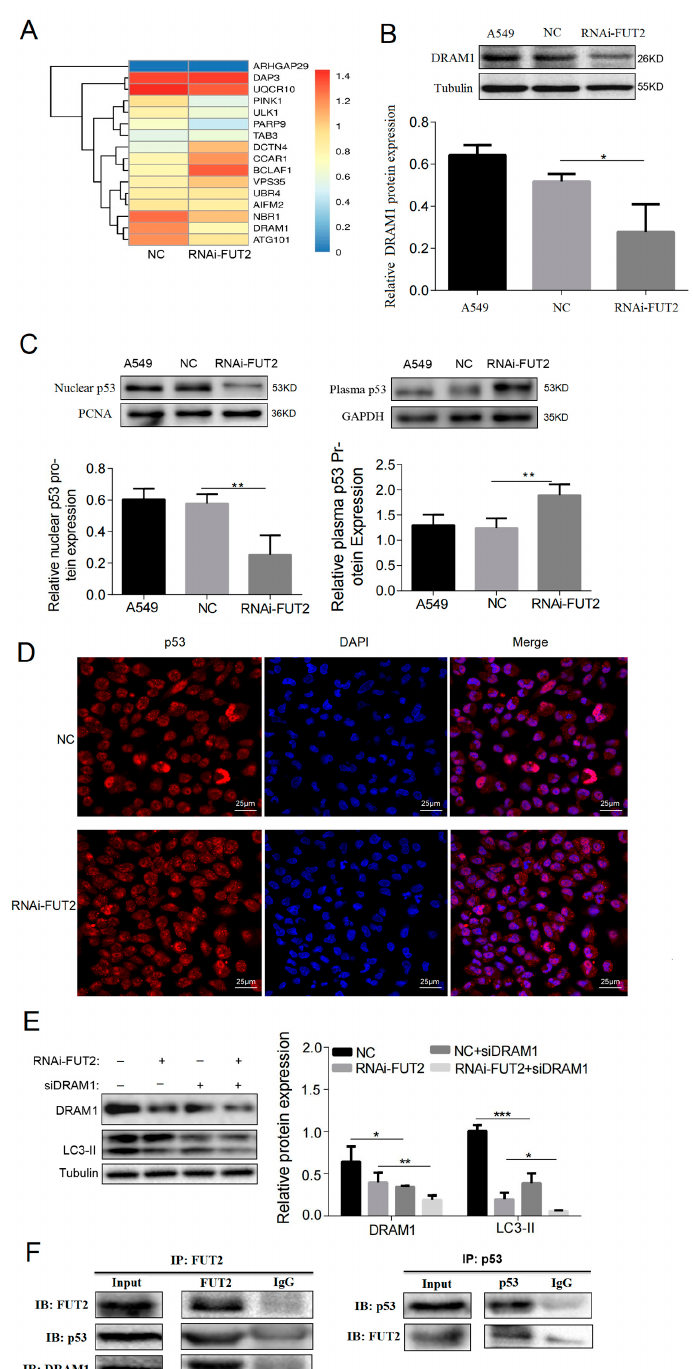
Figure 5. FUT2 stimulates autophagy through the nuclear p53-DRAM1 axis in A549 cells. ( A ) RNA- seq sequencing showing the genes associated with autophagy or apoptosis regulated by FUT2 in A549 cells. ( B ) Representative Western blot showing that the knockdown of FUT2 inhibited the expression of DRAM1 in A549 cells. ( C ) Representative Western blot showing the plasma and nuclear p53 protein levels in A549 cells. ( D ) Representative image of immunofluorescence staining showing the distribution of p53 in FUT2-knockdown A549 cells or control cells. ( E ) Representative Western blot showing the expressions of DRAM1 and LC3-II in FUT2-knockdown A549 cells or control cells in the presence or absence of siDRAM1. ( F ) Co-immunoprecipitation (Co-IP) assay showing an interaction between FUT2 and p53 or DRAM1 in A549 cells. (* p < 0.05, ** p < 0.01, and *** p <